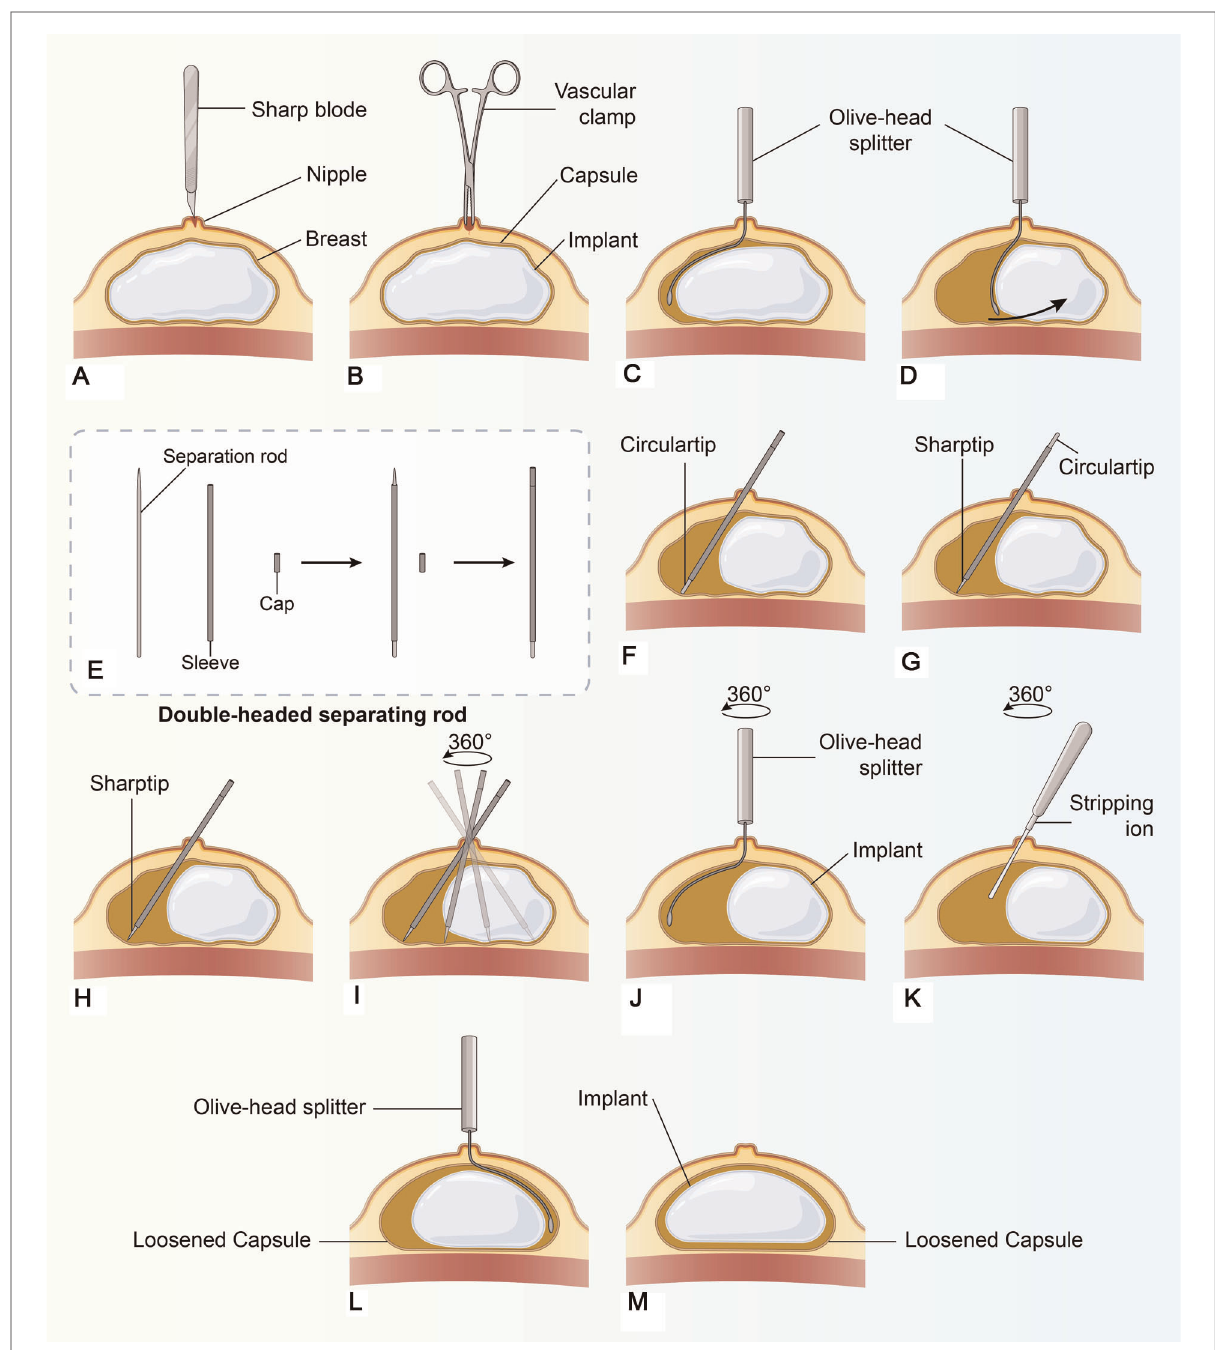
FIGURE 3 Operation fl ow chart of treatment for breast capsular contracture by the punctiform-incision approach through the nipple, as shown in the fi gure: A – M